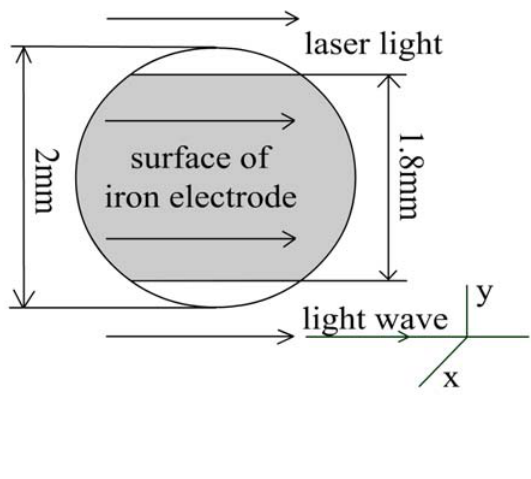
Figure 3. The object wave passing though the electrode surface. The X axis is in horizontal direction from the electrode surface toward the bulk electrolyte while the Y axis in vertical direction is parallel to the surface of